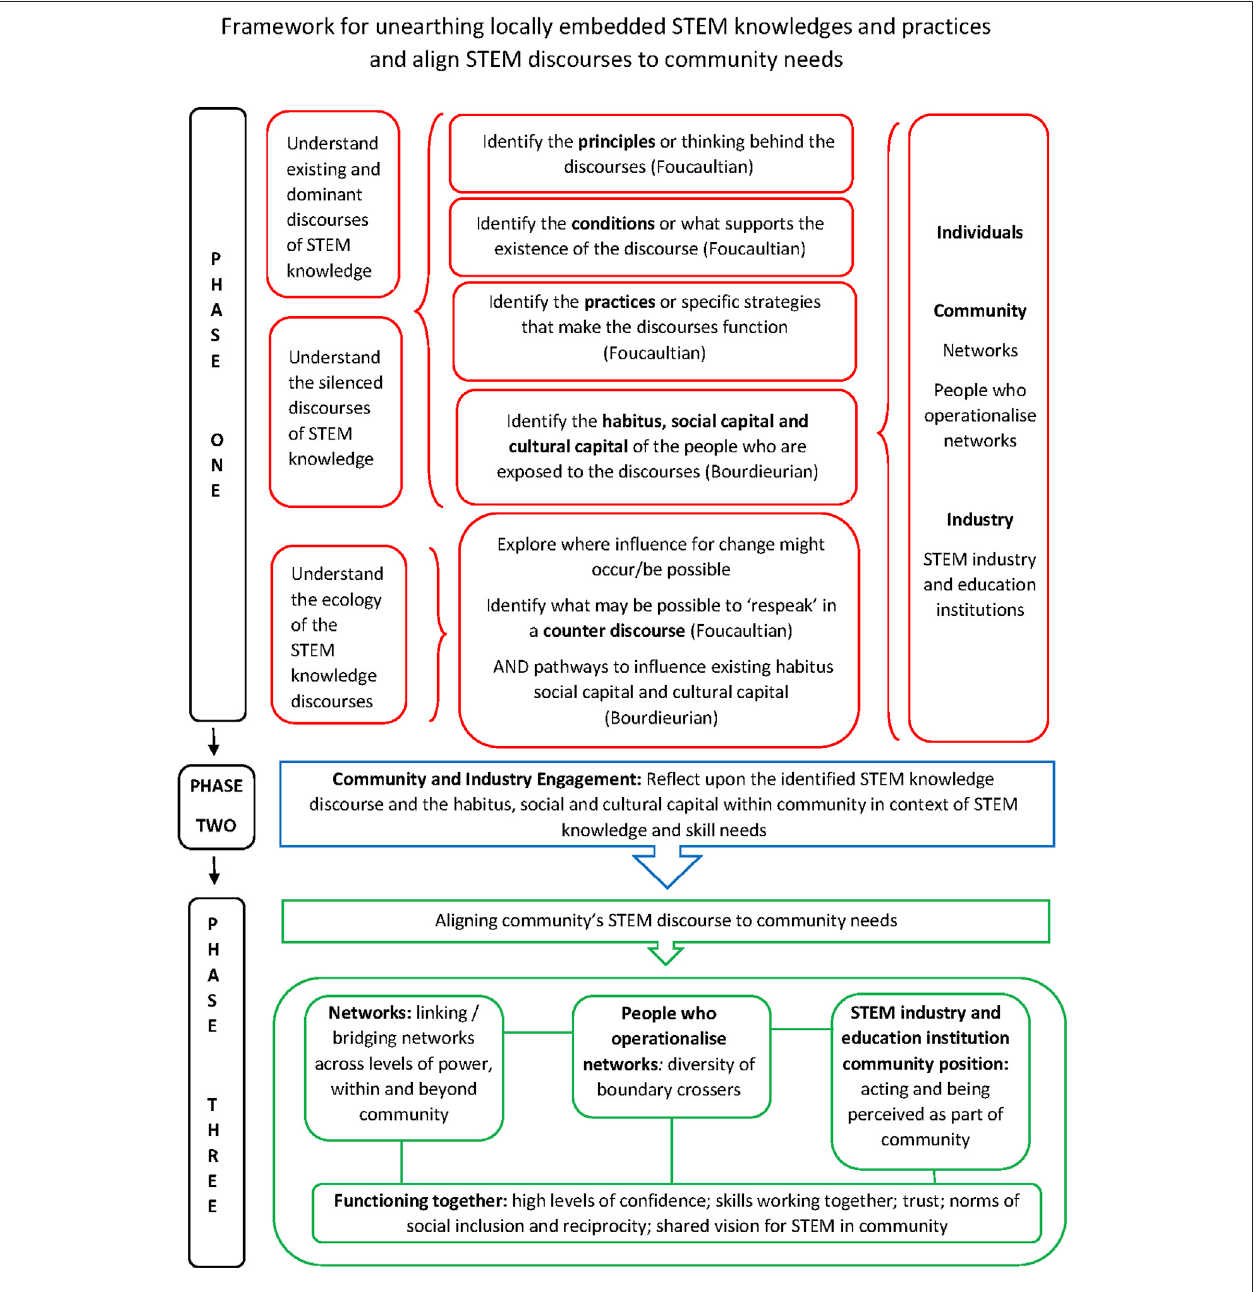
FIGURE 2 | Place-based STEM-alignment